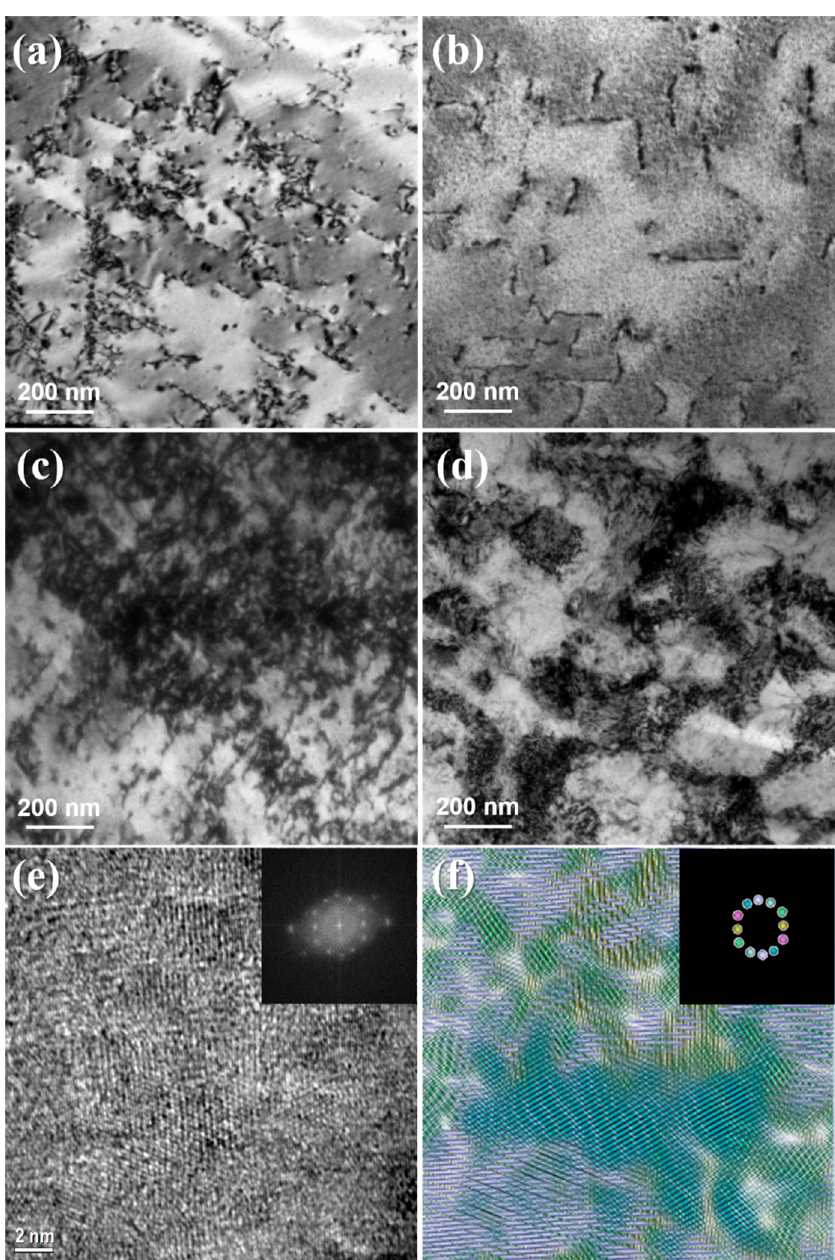
Figure 5. ( a – d ) Transmission electron microscopy (TEM) images of ferrite in the fatigued specimen of the unaged ( a , c ) and aged ( b , d ) under strain amplitude of 0.3% ( a , b ) and 0.6% ( c , d ). ( e ) High resolution TEM image of ferrite in the fatigued specimen aged at 400 °C for 10,000 h. ( f ) The corresponding orientation distribution of ( e ).